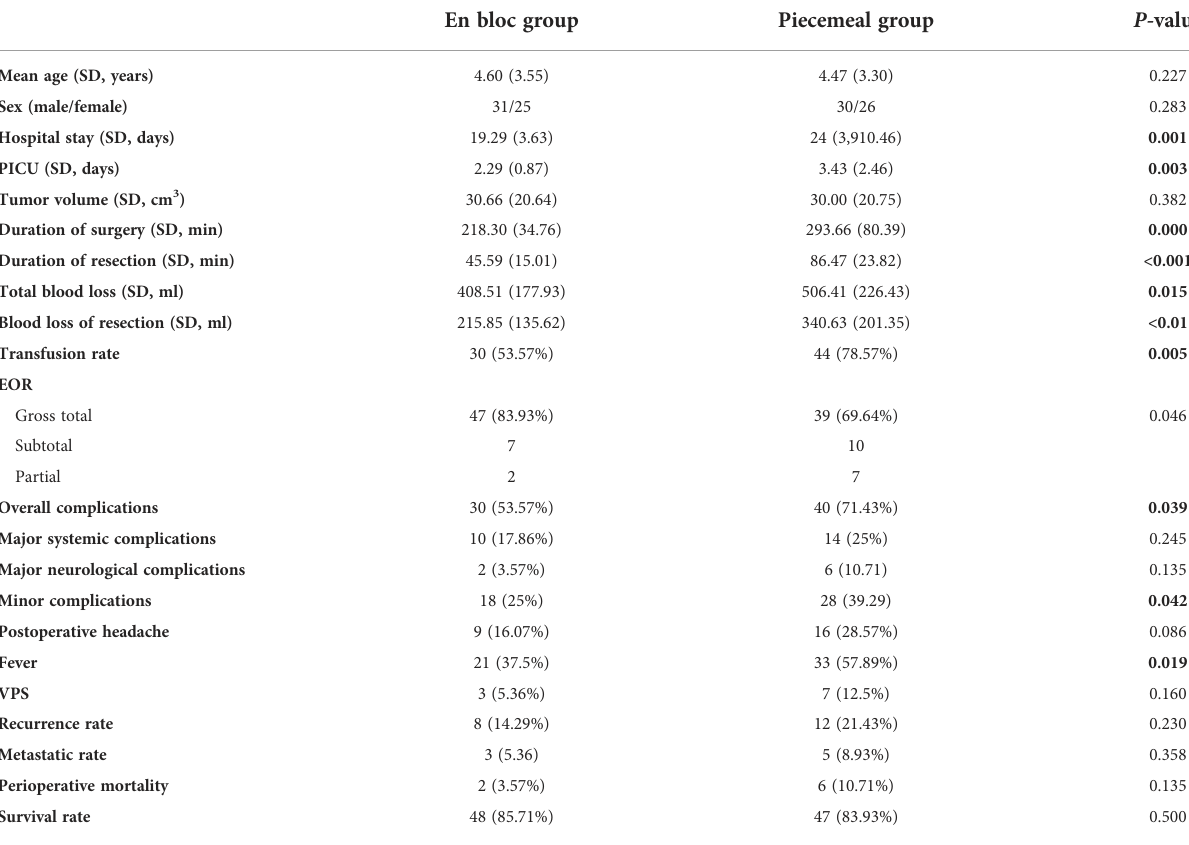
TABLE 1 Short outcomes between the en bloc group and the piecemeal group.